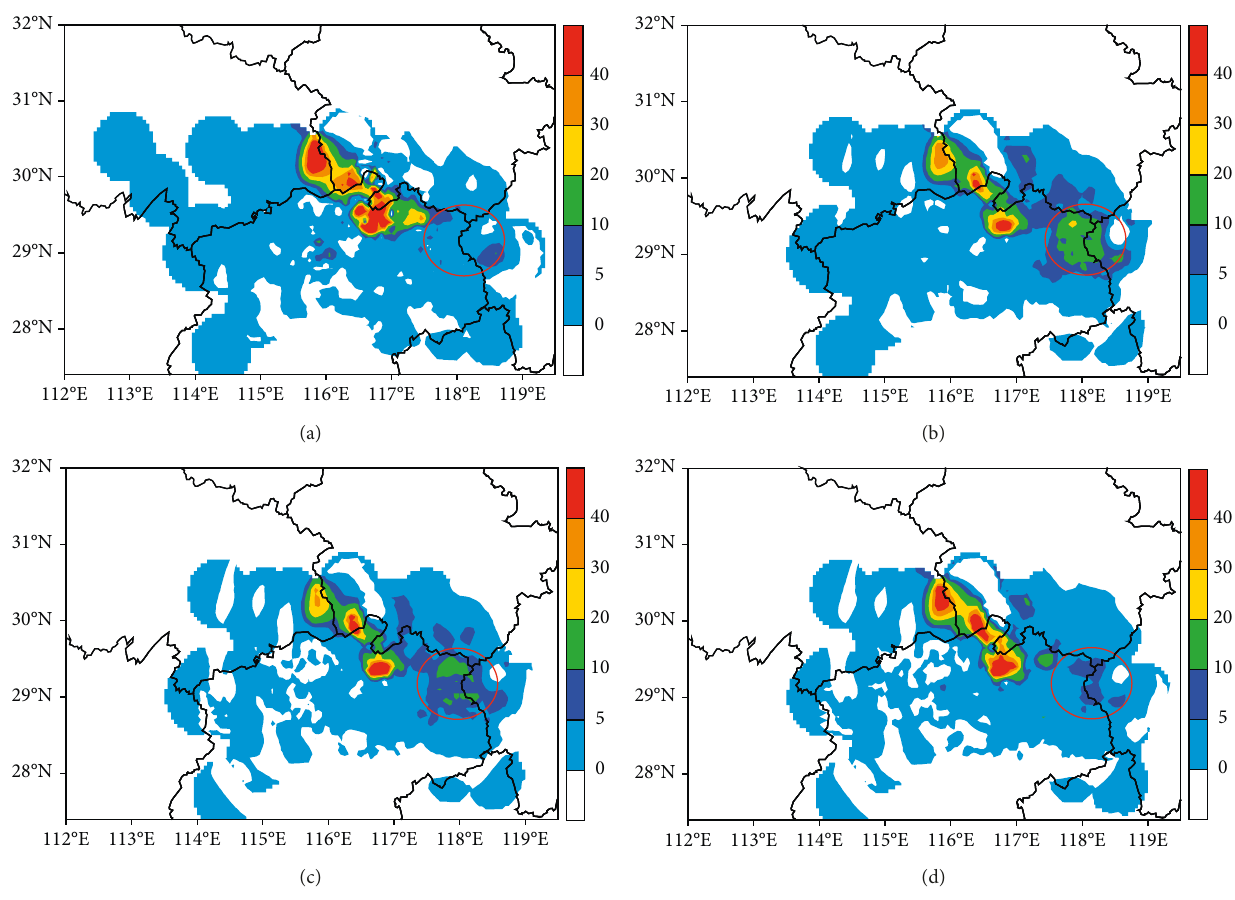
Figure 3: Precipitations (mm) obtained from (a) observation, (b) SM method, (c) EIDM method, and (d) ETDM method at 2200 UTC 18 June